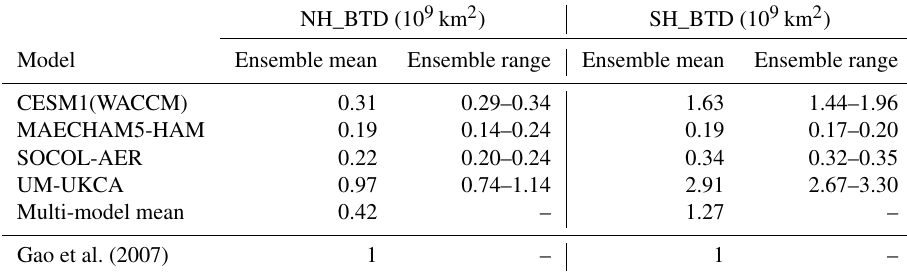
Table 6. Burden-to-deposition (BTD) factors ( × 10 9 km 2 ) between the hemispheric peak sulfate burden (TgSO 4 ) (total atmospheric column burden anomaly) and the mean ice sheet cumulative deposited sulfate (kgSO 4 km − 2 ) for the four models and from Gao et al. (2007). Included are the values for the ensemble mean factor and the range from individual ensemble